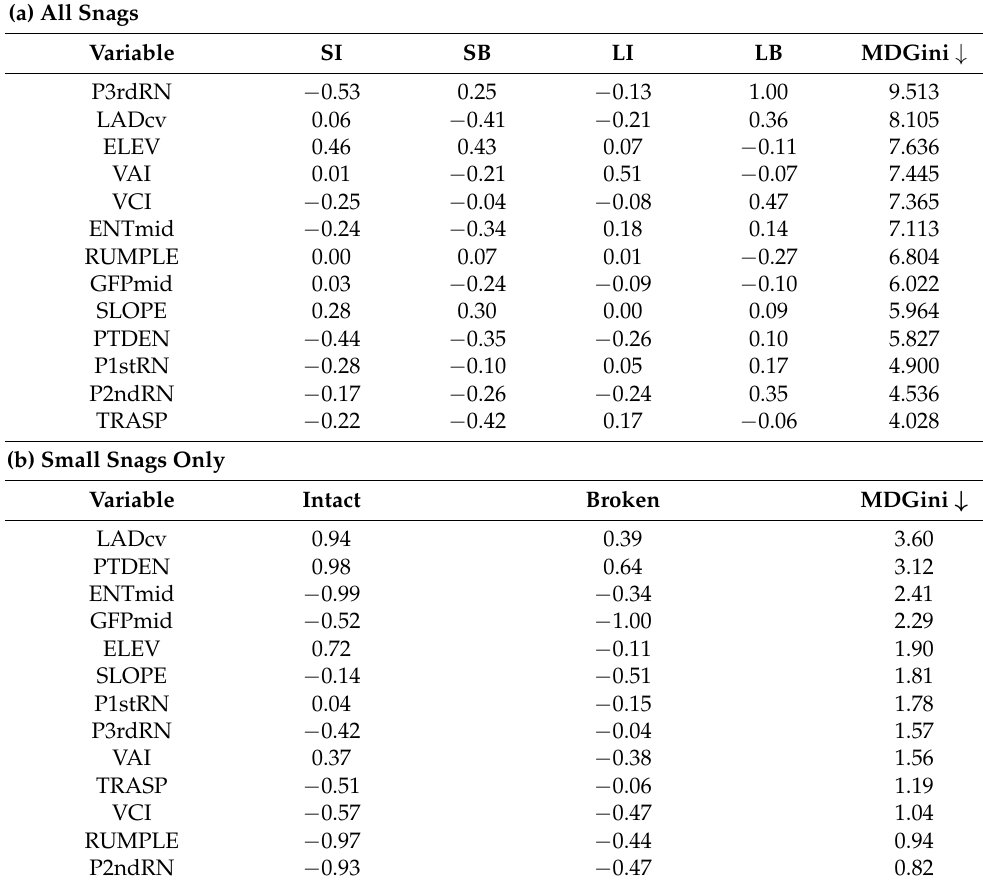
Table 5. Predictor variable importance from the top random forest models for classifying snags within conifer forests in Idaho, USA. There were three RF models used across the full dataset: ( a ) all snags (with four classes: “small intact” (SI), “small broken” (SB), “large intact” (LI), and “large broken” (LB)); ( b ) small-diameter snags only (using intactness as a binary class); and ( c ) large-diameter snags only (using intactness as a binary class). For the class-specific columns, all scores for each class were adjusted via MIR, where each value was divided by the largest absolute value as a means of standardization across models [46]. The mean decrease in Gini (MDGini) refers to the total decrease in node impurities from splitting on that variable averaged over all RF trees [41]. All rows are sorted by MDGini (indicated by the small down arrow), as this was used to rank predictor variables in terms of overall variable